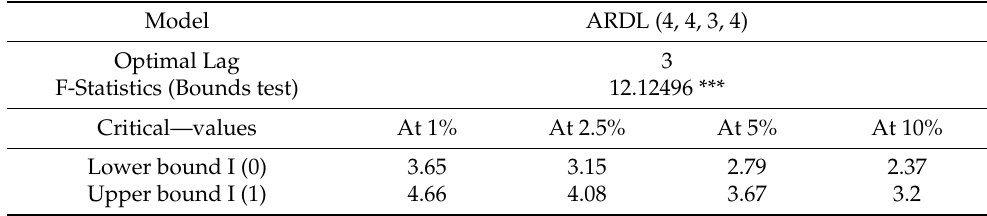
Table 3. Bounds Test for Cointegration Results.